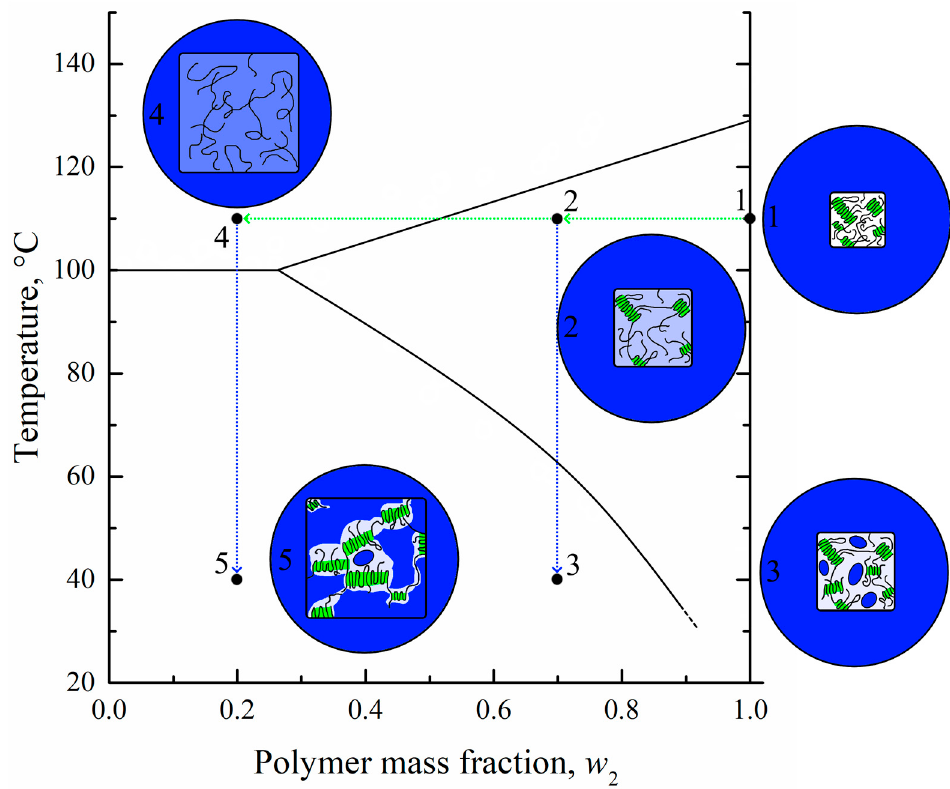
Figure 10. Scheme illustrating the mechanism of the structure formation of membranes by the proposed controlled swelling/deswelling method. Blue color reflects solvent; UHMWPE crystallites are colored green; white and light blue color reflects pure (without solvent) and swollen amorphous regions of UHMWPE, respectively.